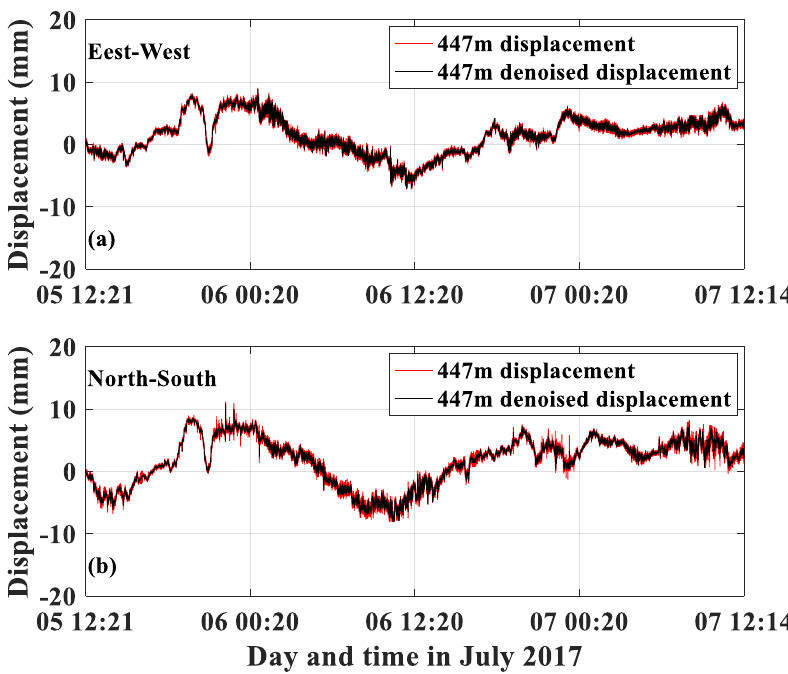
Figure 8. IBIS-S-derived horizontal displacement time series in east–west (a) and north–south (b) directions at 447 m height of the WGC. The red line denotes the displacement time series without denoising, and the black line represents the displacement time series after denoising.